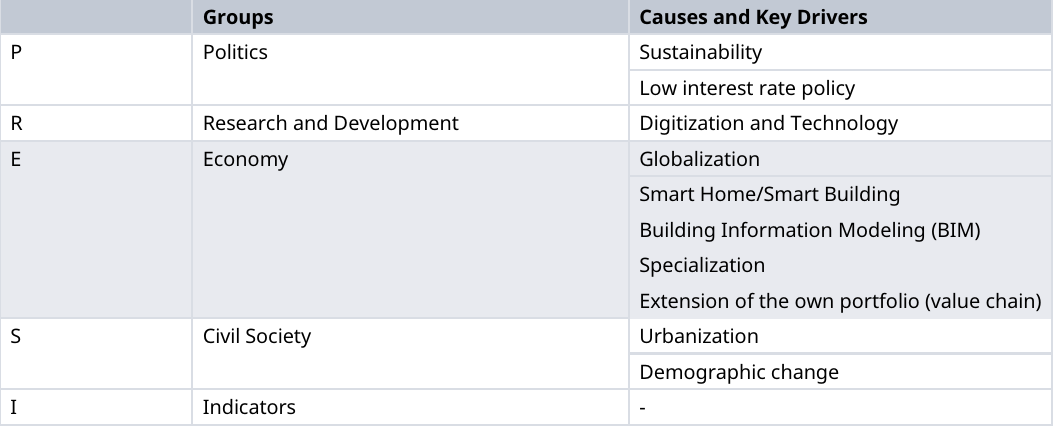
Table 6. Groups of stakeholders and indicators with assigned causes and drivers according to Baumanns.